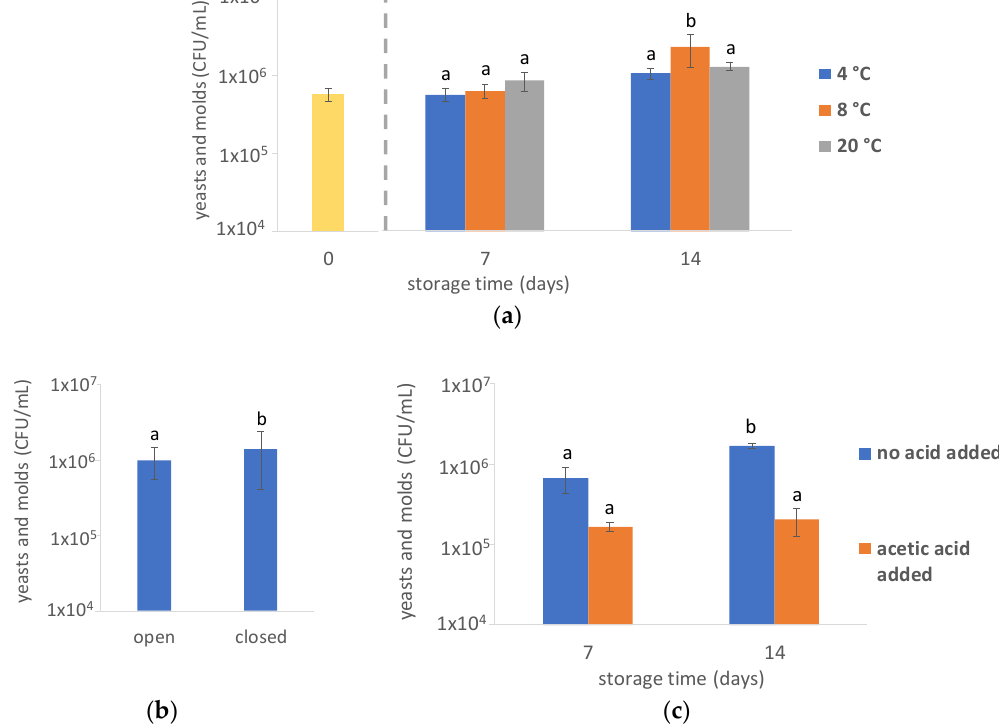
Figure 2. Yeast and mold counts—storage experiment 1. ( a ) Yeast and mold count after 0, 7 and 14 days of storage in algae samples without added acetic acid. ( b ) Effect of storing algae in open or closed recipients without acetic acid addition. ( c ) Effect of acetic acid addition for algae stored at 8 °C in open tubes. Lowercase letters (a,b) denote significant differences. Values within one figure that are not labelled by the same letter are significantly different. The t 0 value was not included in the statistical analysis of the data shown in Figure 1a. Error bars represent standard deviations.